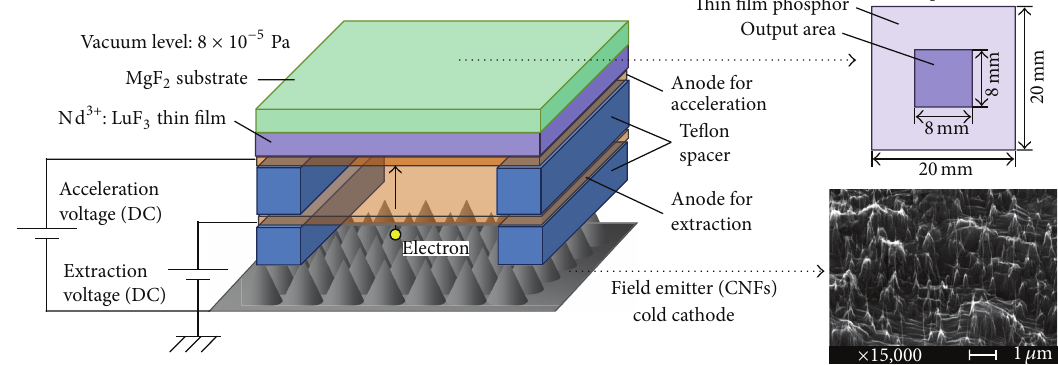
Figure 1: Schematic diagram of VUV field emission lamp. SEM image of CNFs is shown in the